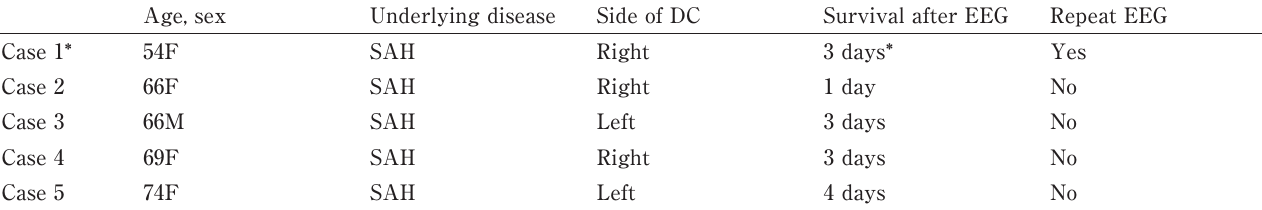
Age, sex Underlying disease Side of